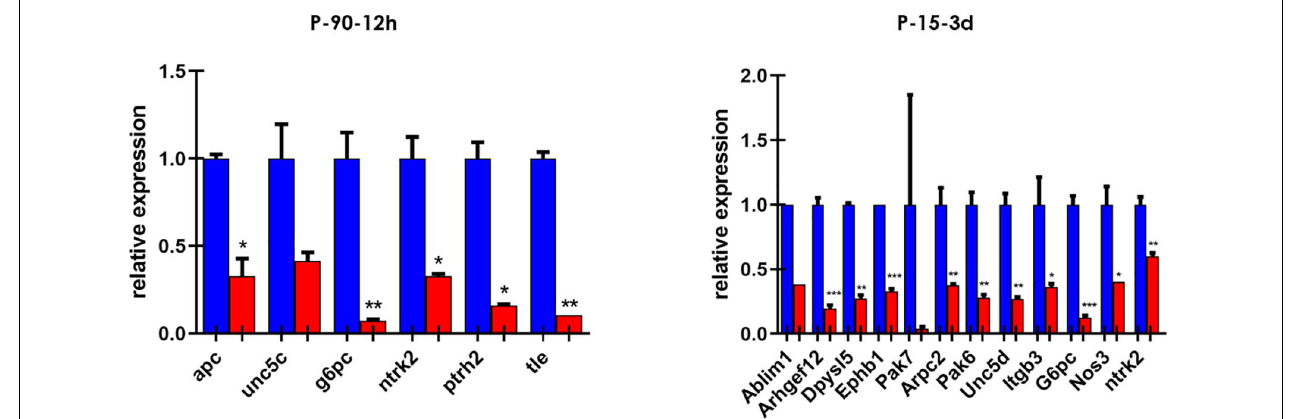
FIGURE 4 | Custom card of putative miR-7b-3p targets. Downregulated genes in P-90-12 h and P-15-3 days experimental groups. Data are shown as normalised relative expression values of technical replicates (RT-PCR, n = 3 technical replicates; *p ≤ 0.04, ** p ≤ 0.09, *** p ≤ 0.0006).